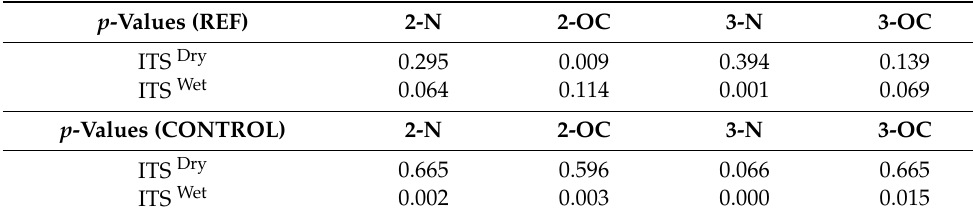
Table 8. p -values (water sensitivity test).